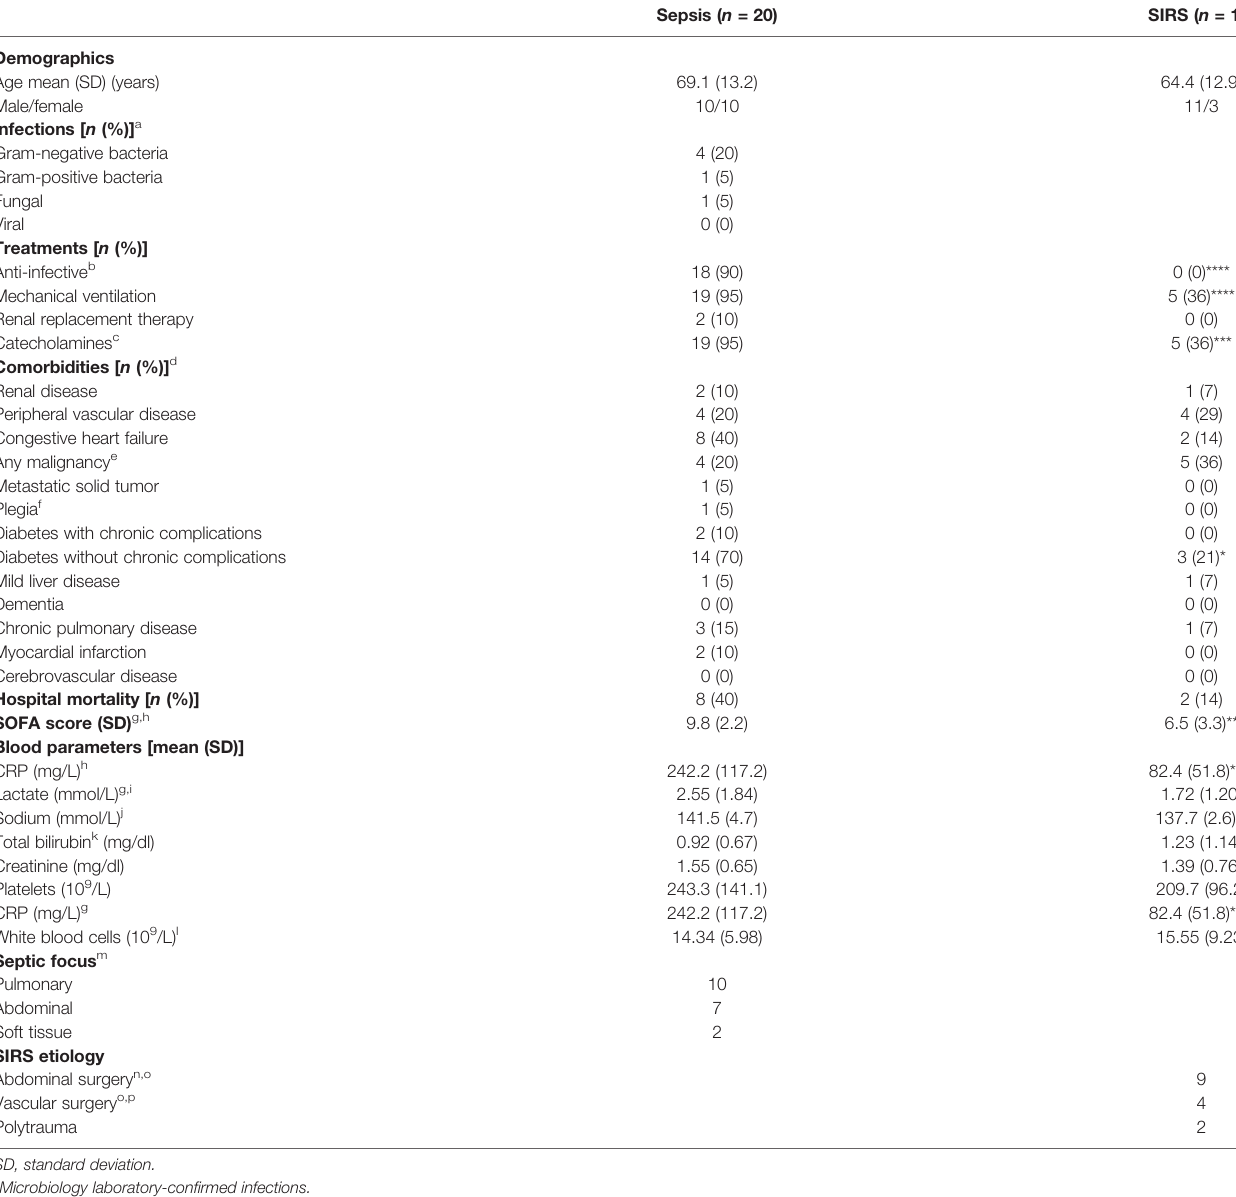
TABLE 2 | ICU patient clinical characteristics for fl ow cytometric analysis of CD15 blood